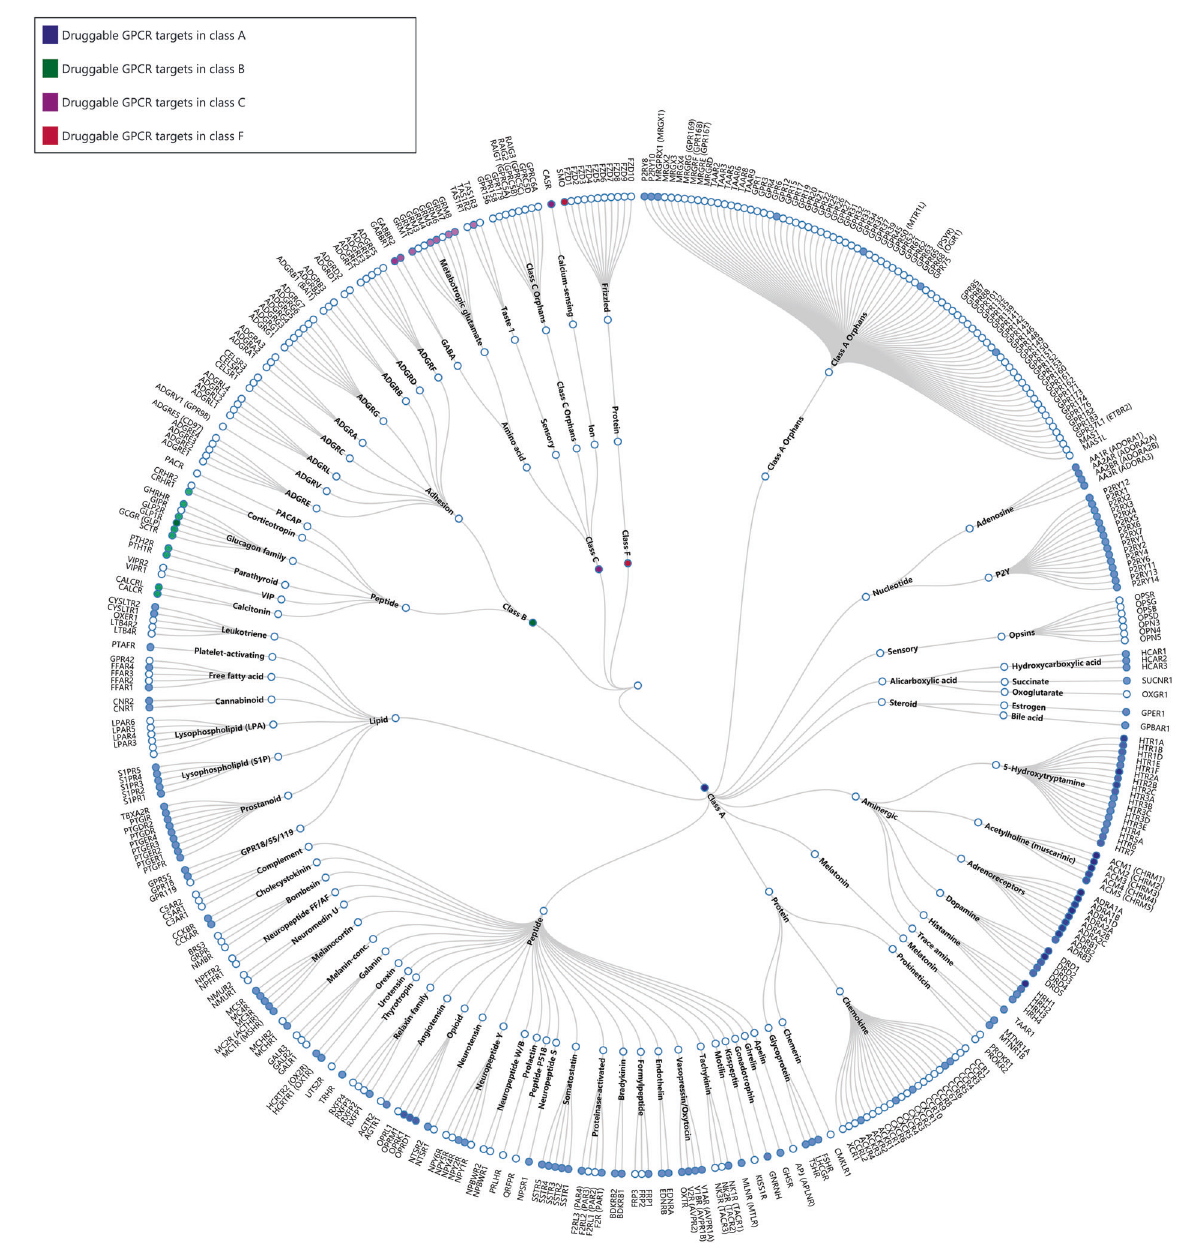
Fig. 1 Phylogenetic tree of GPCRs as drug targets. Node represents GPCR named according to its gene name. Receptors with approved drugs on the market are highlighted by color. GPCRs are organized according to GPCR database. 4 Approved drug list was derived from previous publications, 4,11 complemented by additional search of newly approved entities at Drugs@FDA (accessdata.fda.gov) until June 2020. See Table S2 for